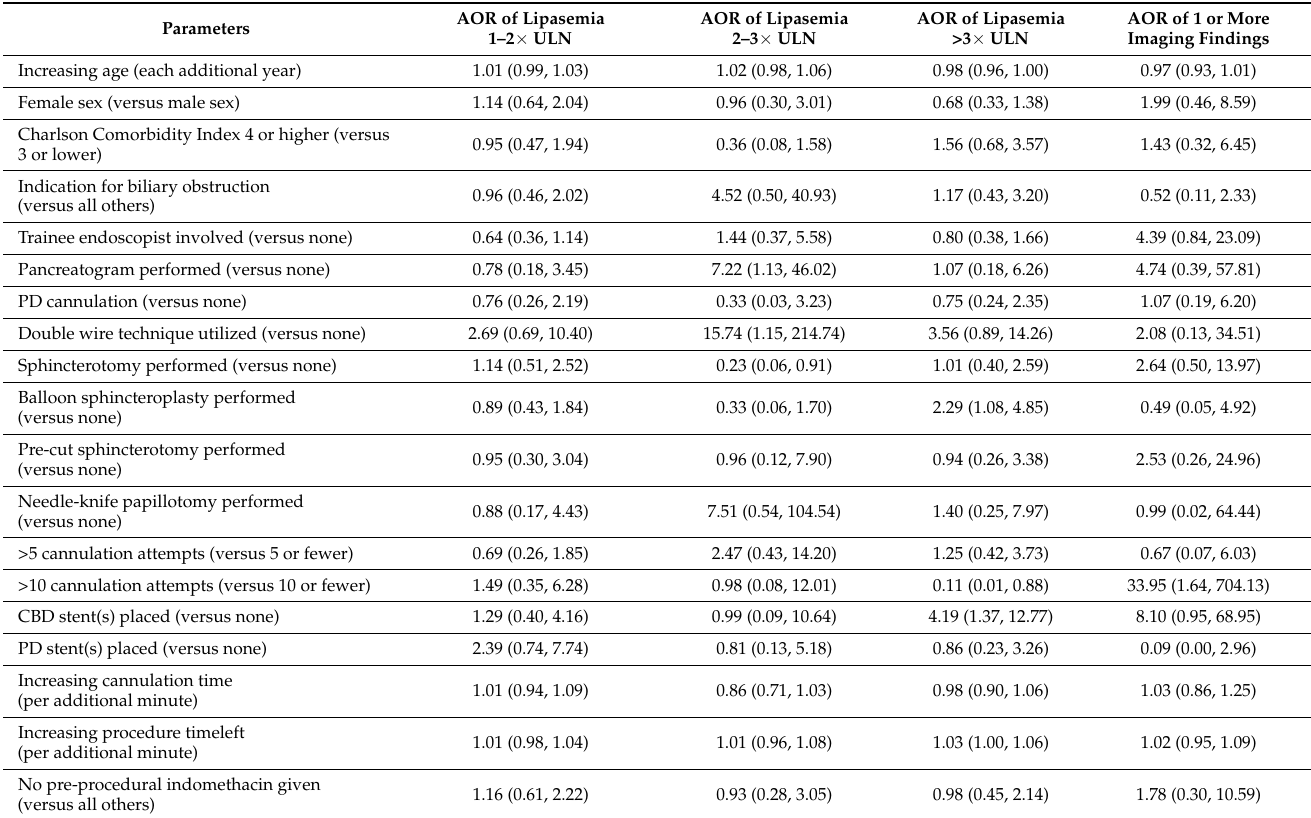
Table 3. Adjusted odds ratios of incidental biochemical and radiologic findings after